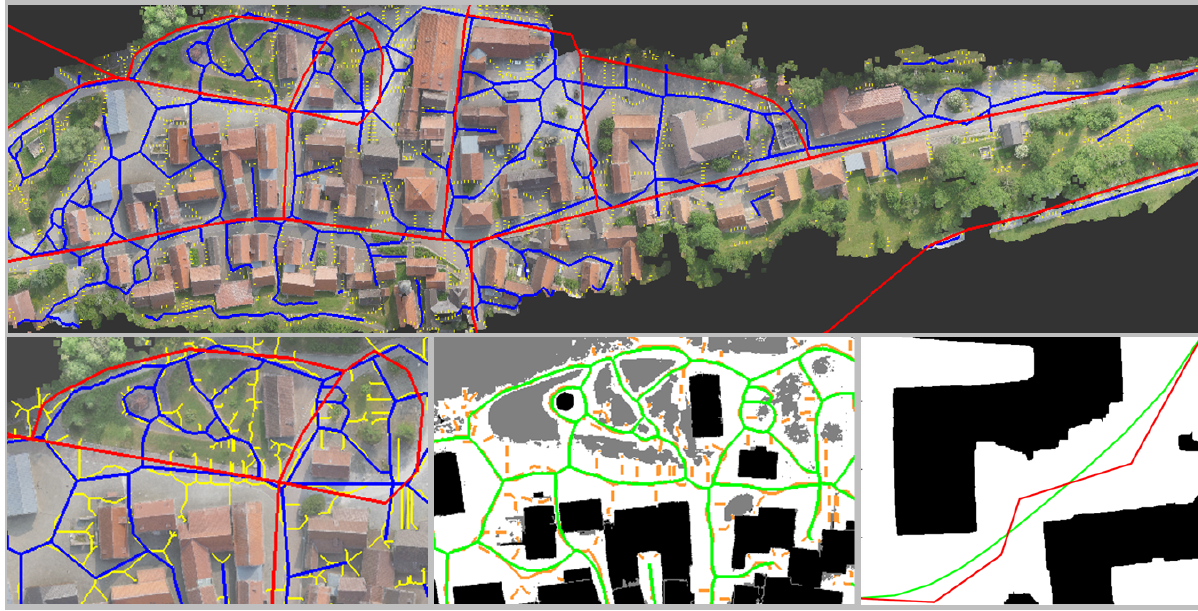
Figure 3: Results for the dataset Bonnland . Top row: road segments drawn into the orthophoto. Bottom row: detailed result plotted into the orthophoto (left) and the corresponding fragment for the classification mask (black: building class, white: road class, gray: remaining pixels, middle). Bottom right, another example for the method based on Bzier curves. See text for more